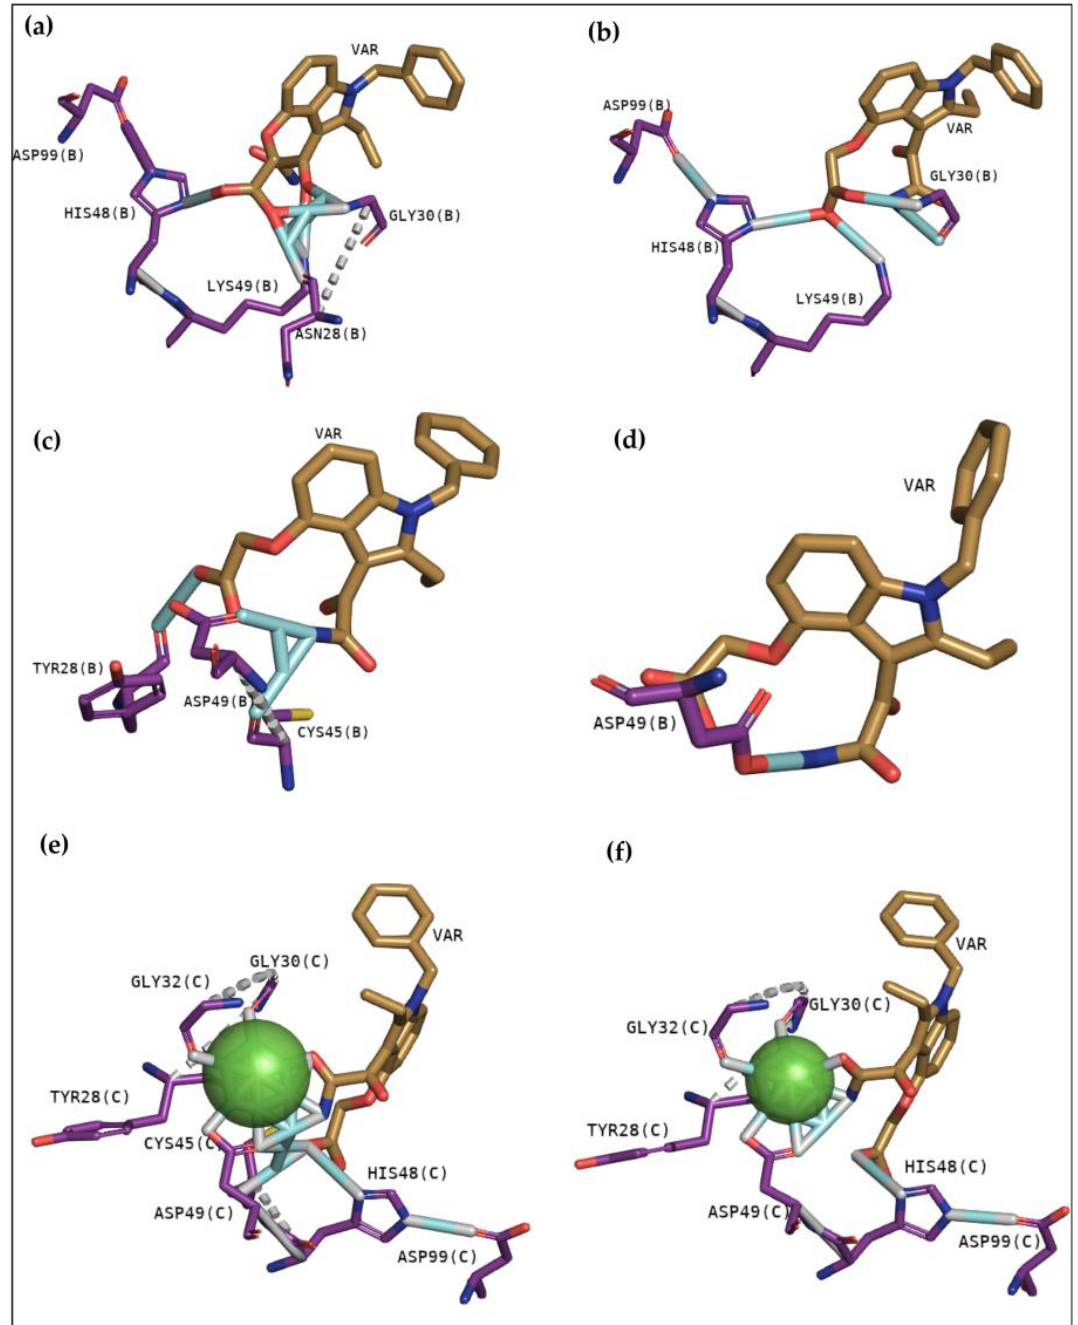
Figure 5. Var docking results with BthTX-I in the first cluster, ( a ) and second cluster ( b ) revealing hydrogen bonds with Gly30, His48 and Lys49. BthTX-II-Var in the first cluster ( c ), with hydrogen bonds with Asp49 and Tyr28, and just with Asp49 in the second cluster ( d ). CdtsPLA2 anchoring with Var, exhibiting strong interactions with the active site and calcium binding loop in the first ( e ) and second ( f ) cluster. Blue cylinders represent hydrogen bonds between residues and the com- pound.